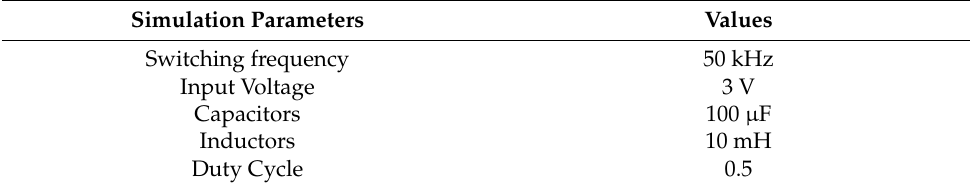
Table 1. Simulation parameters.